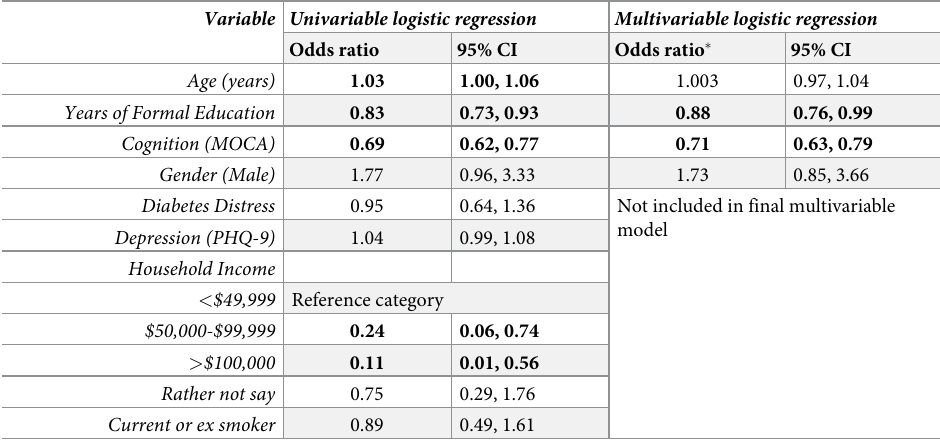
Table 2. Estimated odds ratios and 95% confidence intervals (CI) from logistic regression models of functional health literacy and patient risk factors. Variable Univariable logistic